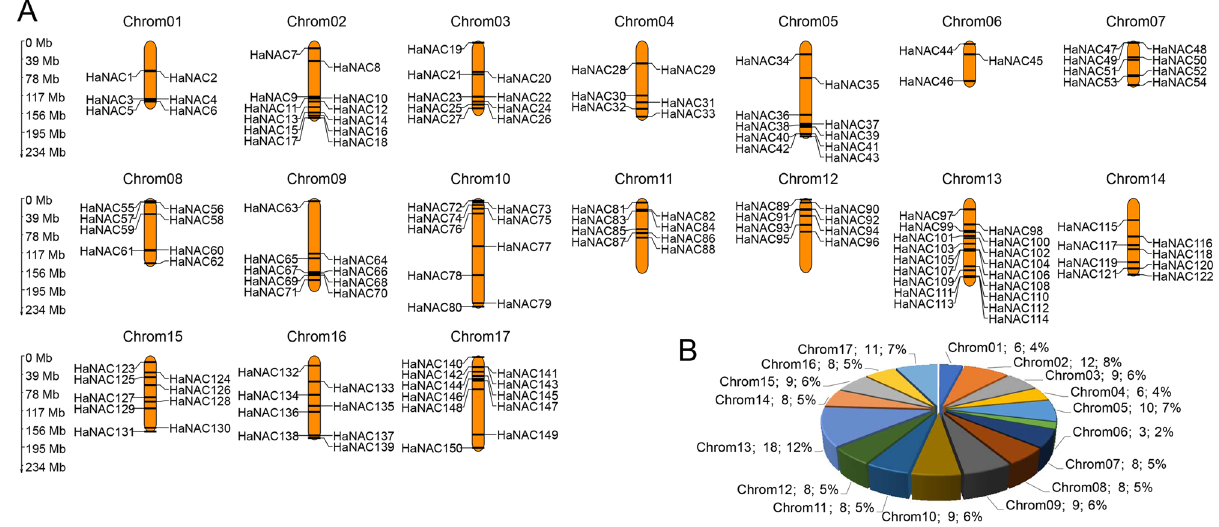
Figure 1. Distribution of HaNACs on all 17 sunflower chromosomes. ( A ) The size of each chromosome and its corresponding HaNACs distribution; ( B ) The pie chart showed the number and percentage of HaNACs on each